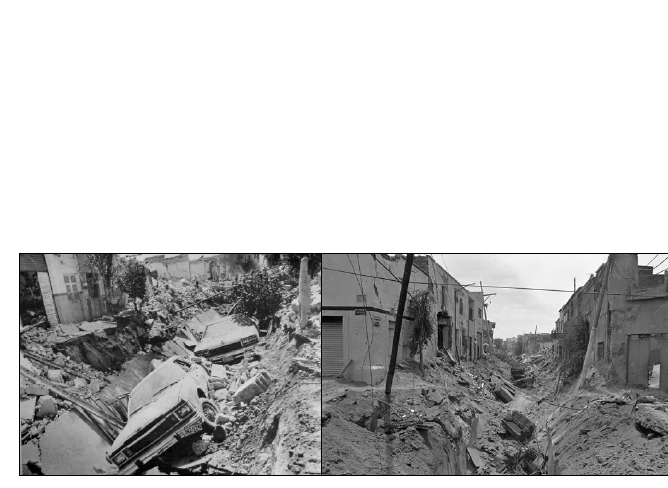
Figure 11 – Aftermath of the Guadalajara sewer explosions Рис . 11 – Последствия взрыва канализации в Гвадалахаре Slika 11 – Posledice eksplozije kanalizacije u Gvadalahari